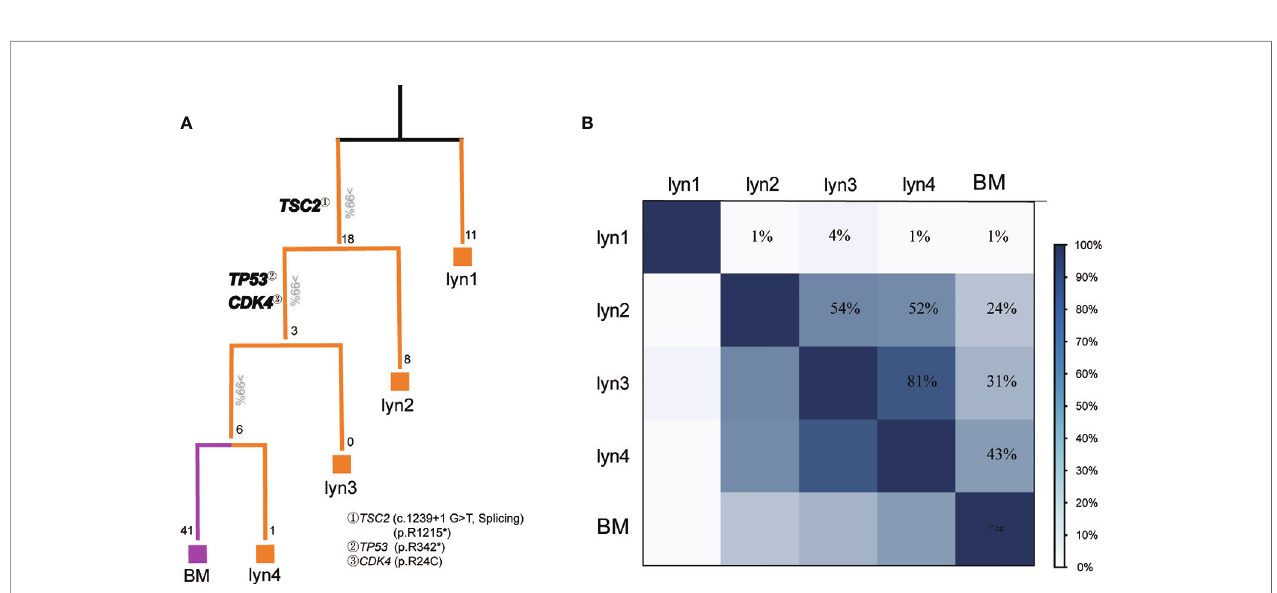
FIGURE 3 | longitudinal evolution pattern and similarity among metastatic lesions. (A) Phylogenetic trees were reconstructed with phylogenomic methods and scaled to demonstrate the metastatic pattern. Numbers on the top of each branch represented the number of shared somatic coding/spicing mutations, numbers at the end of each branch represented acquired private mutations, potential driver gene mutations were illustrated in bold; (B) Genetic similarity analysis between each metastatic lesion.